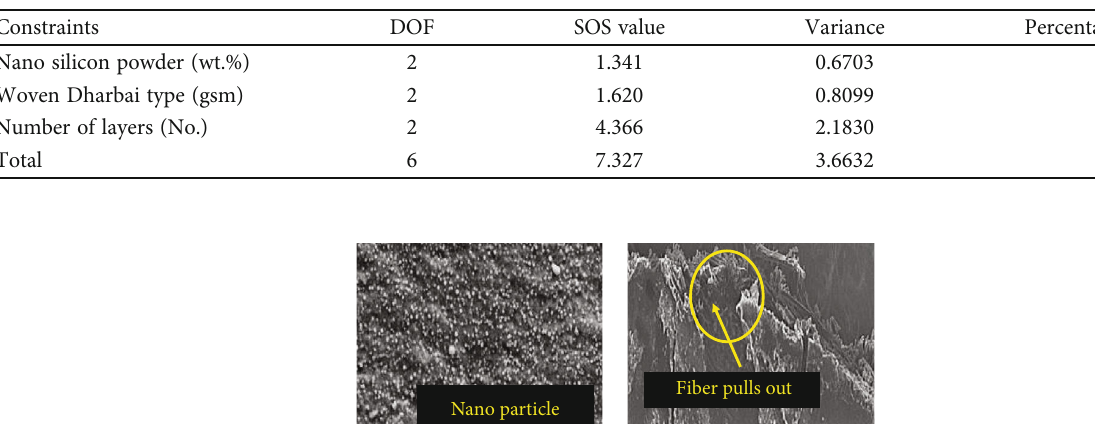
Table 6: ANOVA for ILSS strength of nanocomposites.